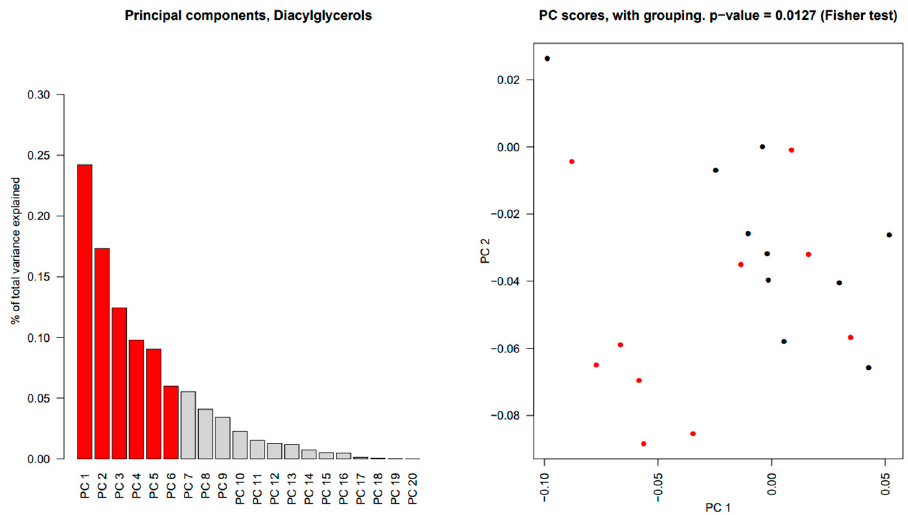
Figure 3. Principal component analysis results of diacylglycerols in stimulated whole saliva. In the ( left panel ), a bar plot of the percentage of the total data variation explained by each estimated principal component; the first 6 principal components (in red) jointly explain 70% of the total data variability. In the ( right panel ), a scatterplot of the principal component scores corresponding to the first two principal components, for primary Sjögren’s syndrome ( • ) and control subjects ( • ). Principal components analysis showed a significant difference of p = 0.0127.